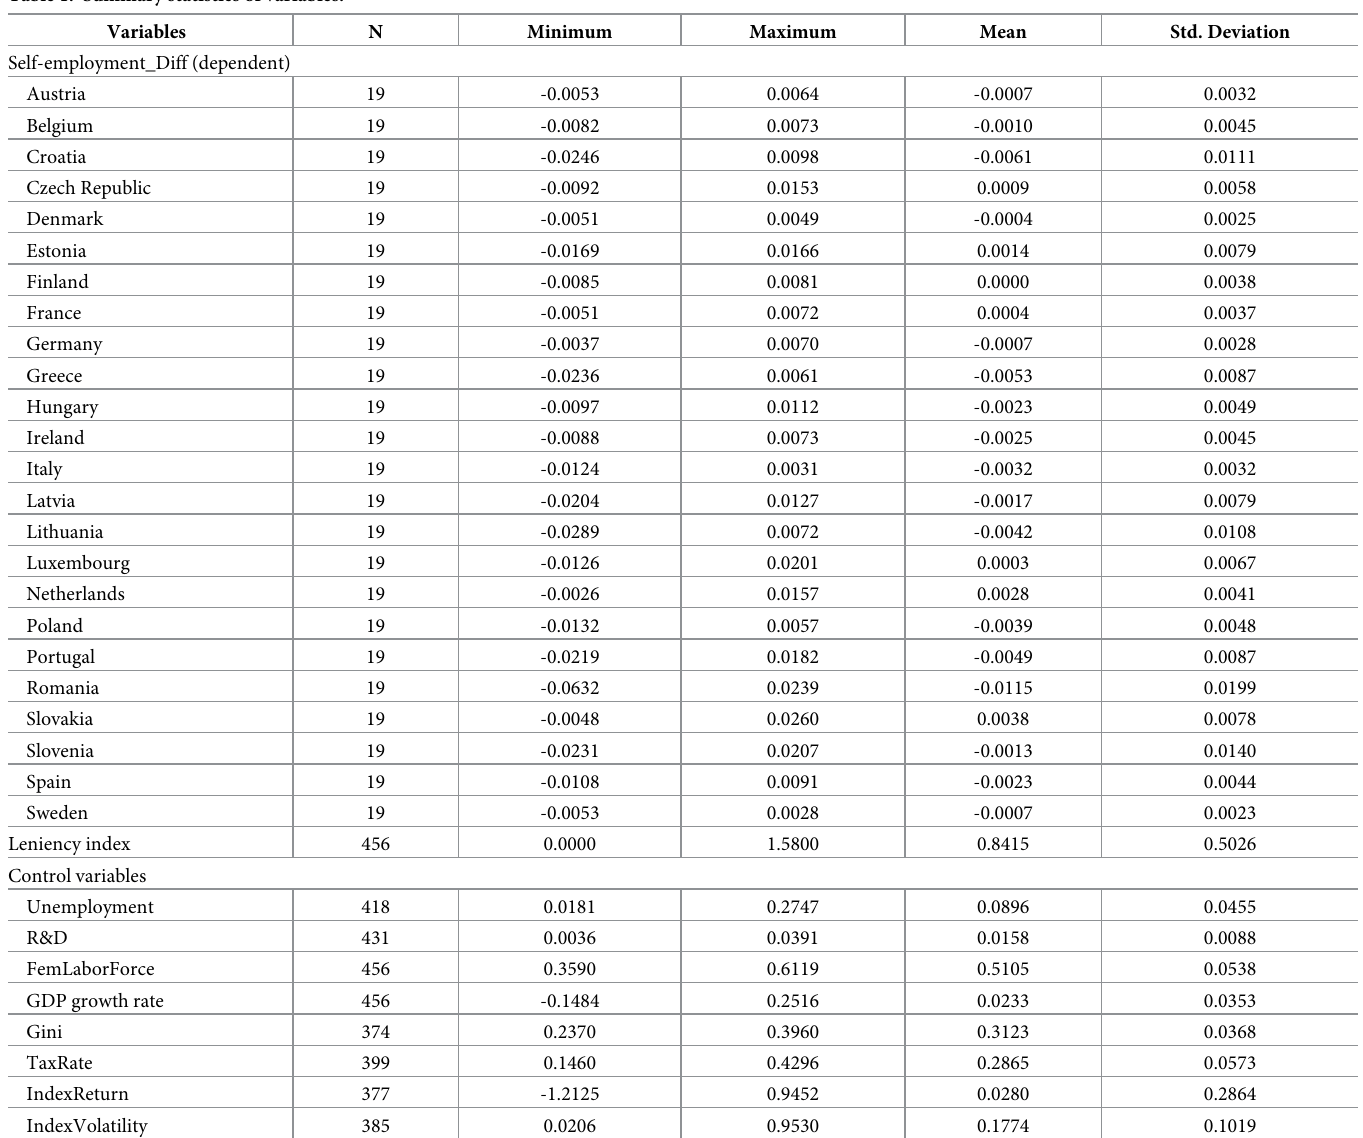
Table 1. Summary statistics of